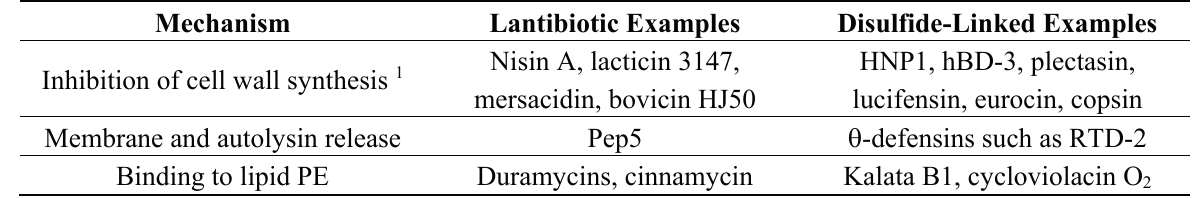
Table 2. Mechanistic similarities between thioether-bonded lantibiotics and disulfide-boned peptides.